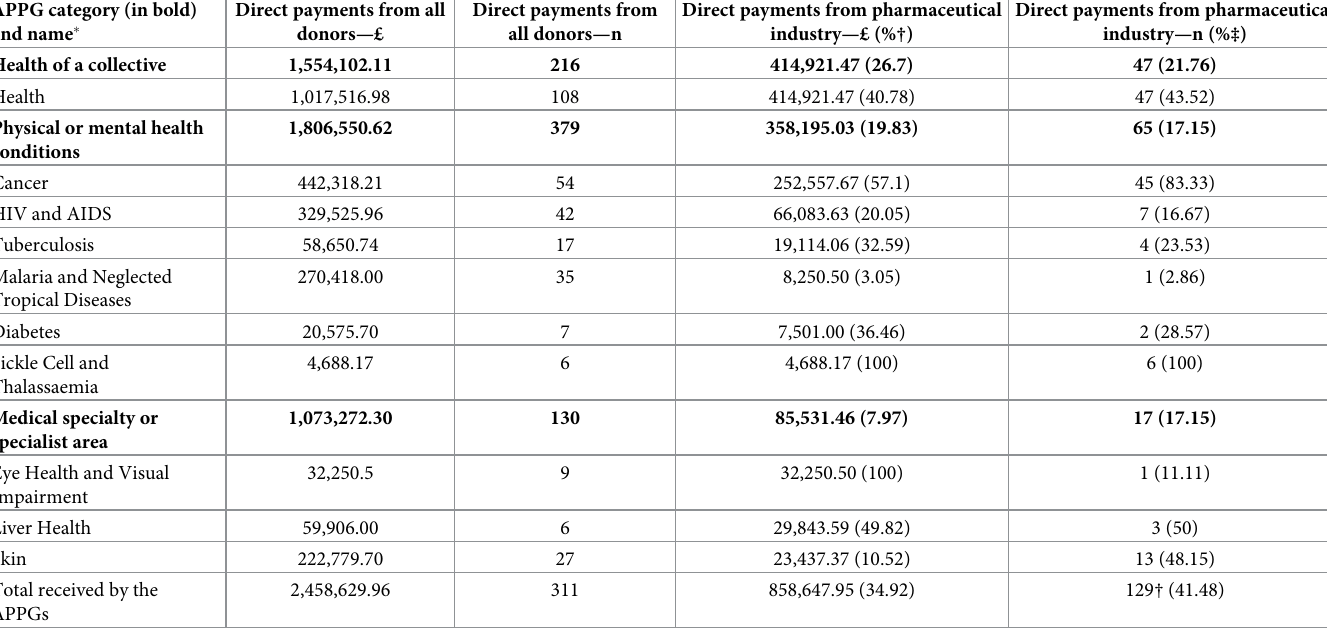
Table 2. Direct payments from pharmaceutical companies received by health related